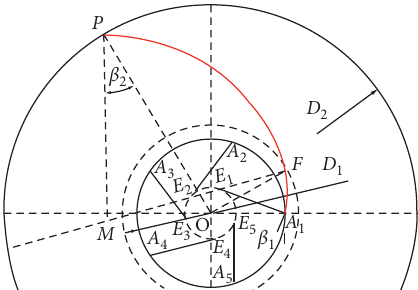
Figure 2: Blade profile of double arc method.